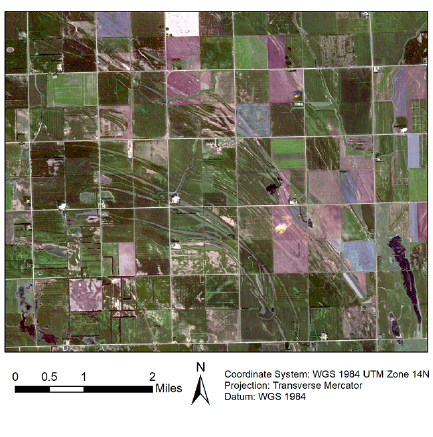
Figure 5. Study Area.